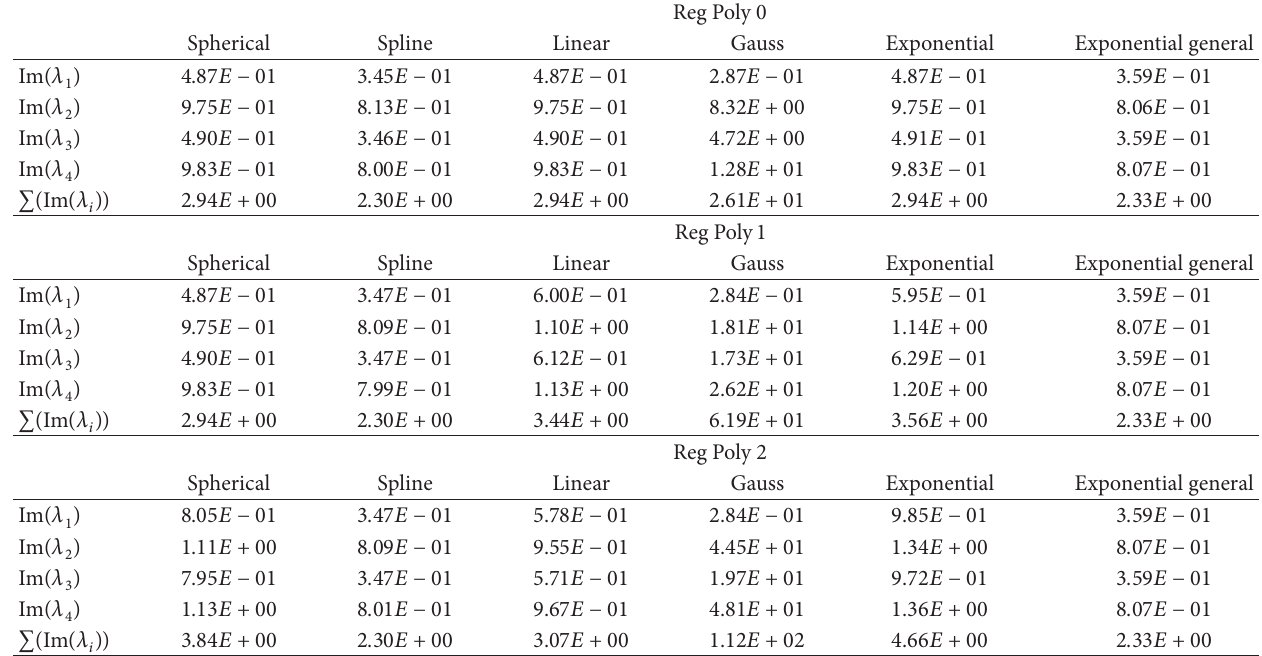
Table 6: Configuration 1: maximum of absolute error on imaginary parts of eigenvalues for different regression and correlation kriging